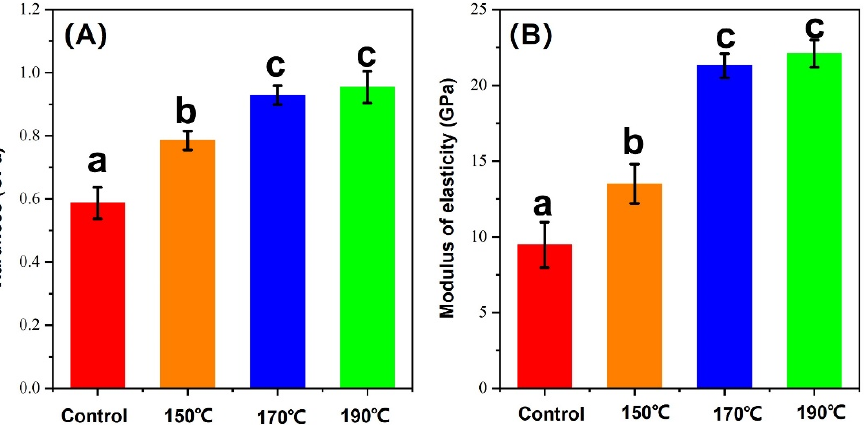
Figure 10. Micro-mechanical properties of treated bamboo samples at different times and the same temperature: ( A ) hardness; ( B ) modulus of